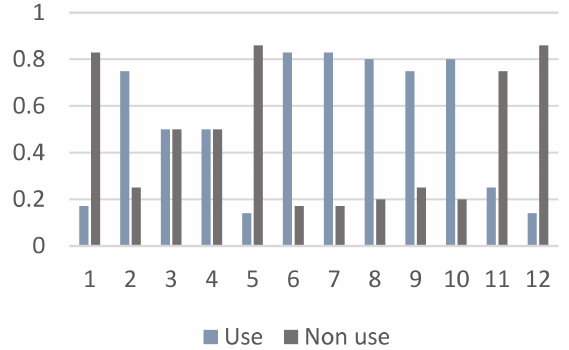
Figure 5. Use/non-use individual preference